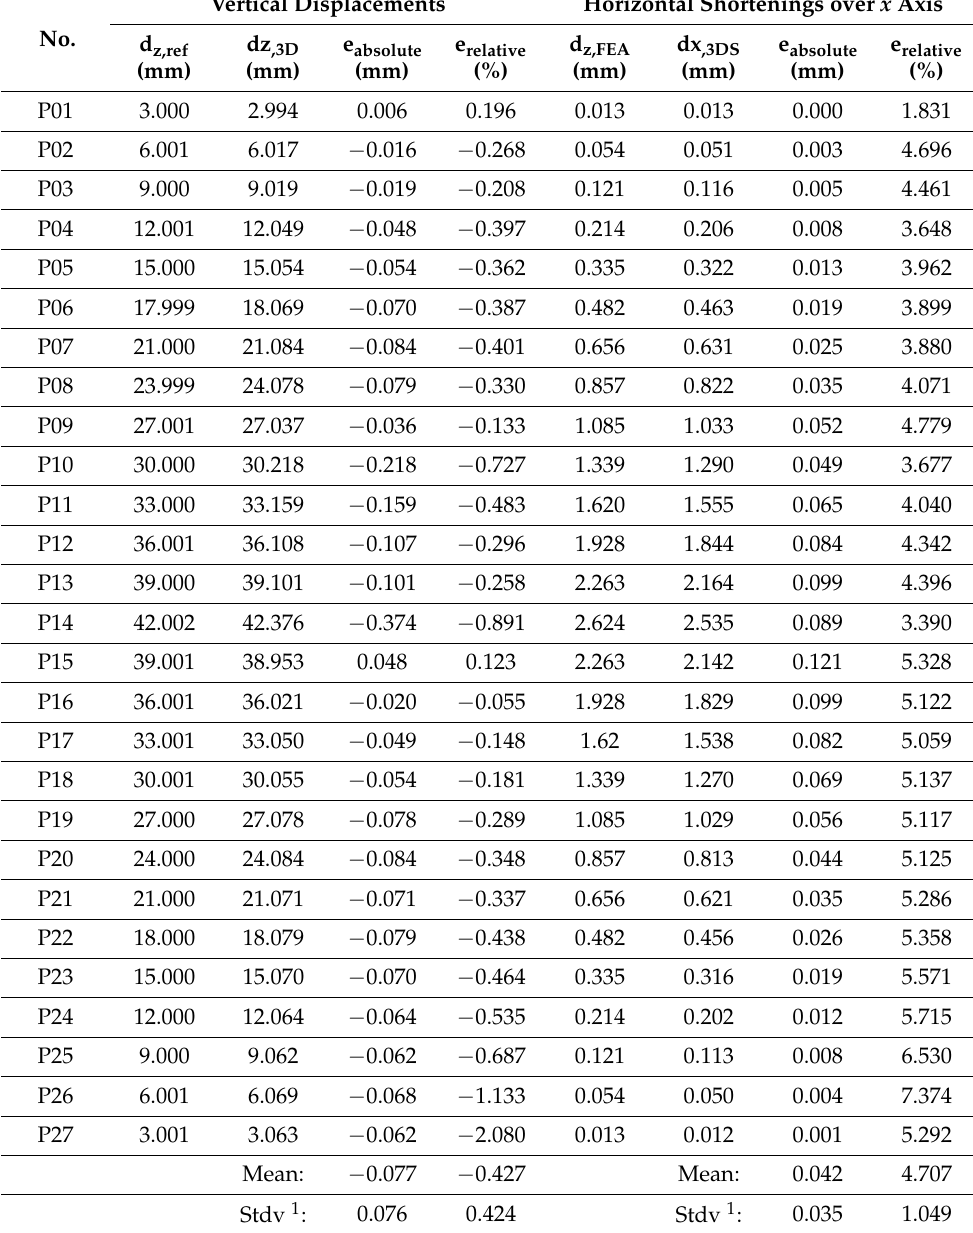
Table 3. Example results from cantilever 3DSensor with error